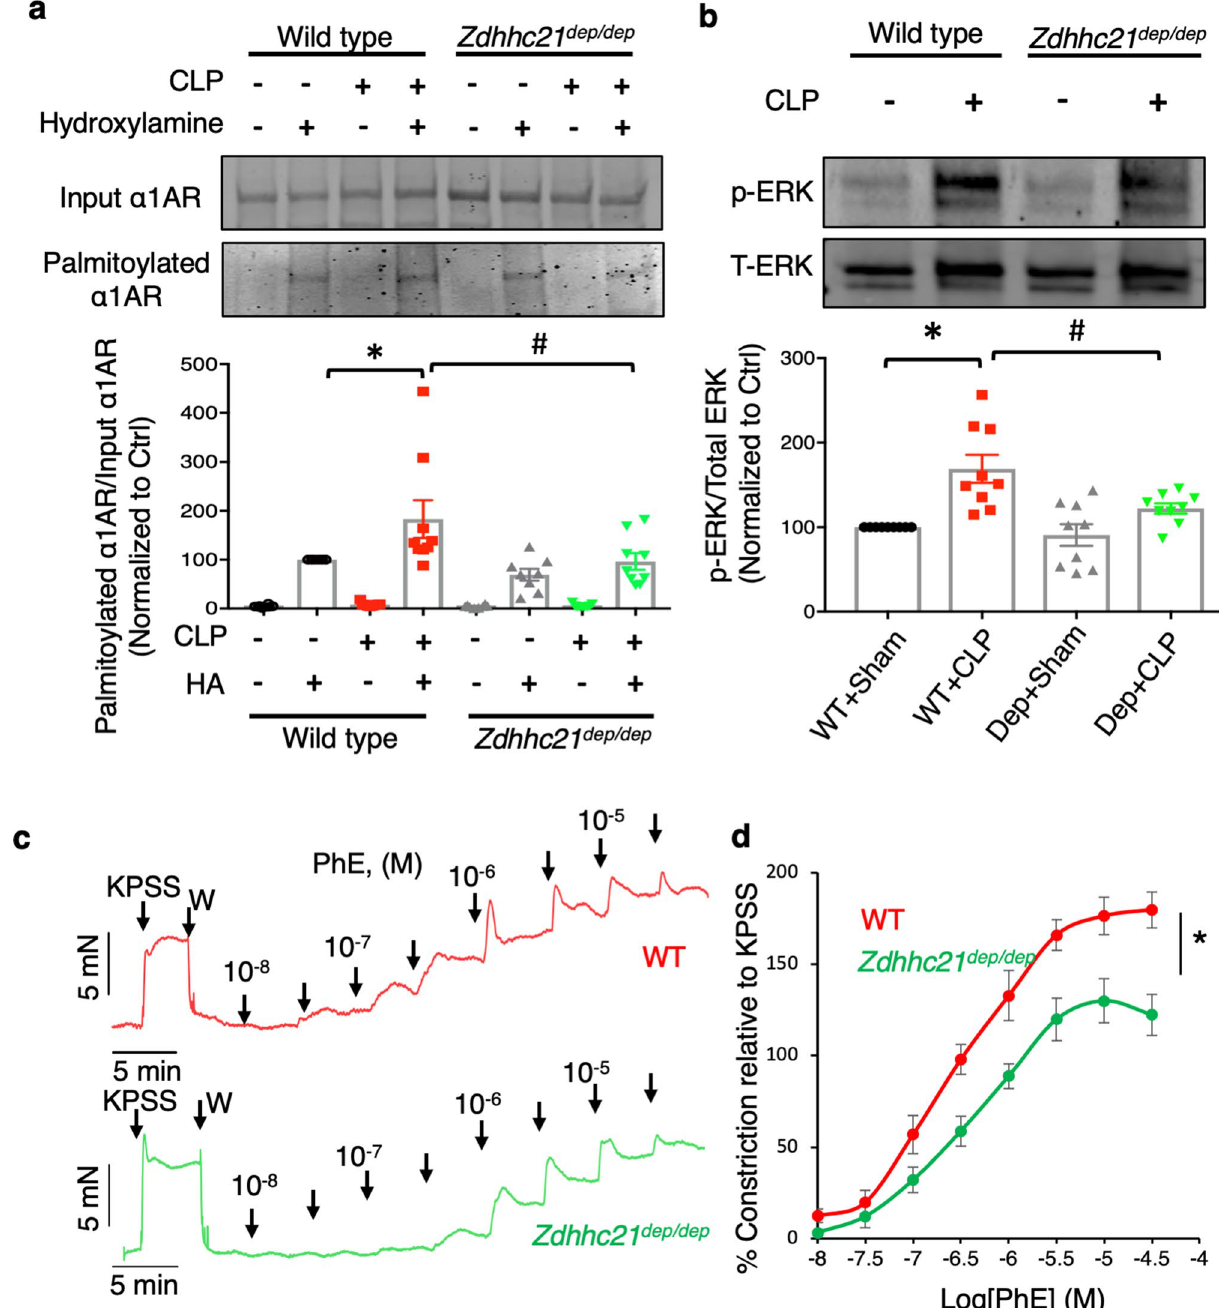
Figure 6. DHHC21 catalyzes α1AR palmitoylation and contributes to α1AR-mediated signaling pathway activation and vasoconstriction. ( a ) The level of palmitoylated α1AR in renal arteries. Palmitoylated proteins were isolated by RAC in the presence of hydroxylamine and then analyzed via immunoblotting for α1AR. Blots are representative of 8 independent experiments; renal arteries from 12 mice were pooled for each independent immunoblot analysis. Band intensity is quantified and normalized to control. Full-length blots are presented in Supplementary Fig. S5a. ( b ) Septic injury-induced ERK activation is inhibited in Zdhhc21 dep/dep mice. The band intensity of phosphorylated ERK is normalized to that of total ERK. n = 9. *p ≤ 0.05 versus WT + Sham, # p ≤ 0.05 versus WT + CLP. Full-length blots are presented in Supplementary Fig. S5b. ( c ) Representative myograph recordings of WT and Zdhhc21 dep/dep renal arteries. KPSS represents 60 mM potassium physiological saline solution; W represents wash. ( d ) Myograph results show that renal arteries of Zdhhc21 dep/dep mice exhibit reduced tension compared to those of WT mice upon phenylephrine challenge. Results represent mean ± SEM. n = 9 mice. One artery per animal was used. *p ≤ 0.05 versus